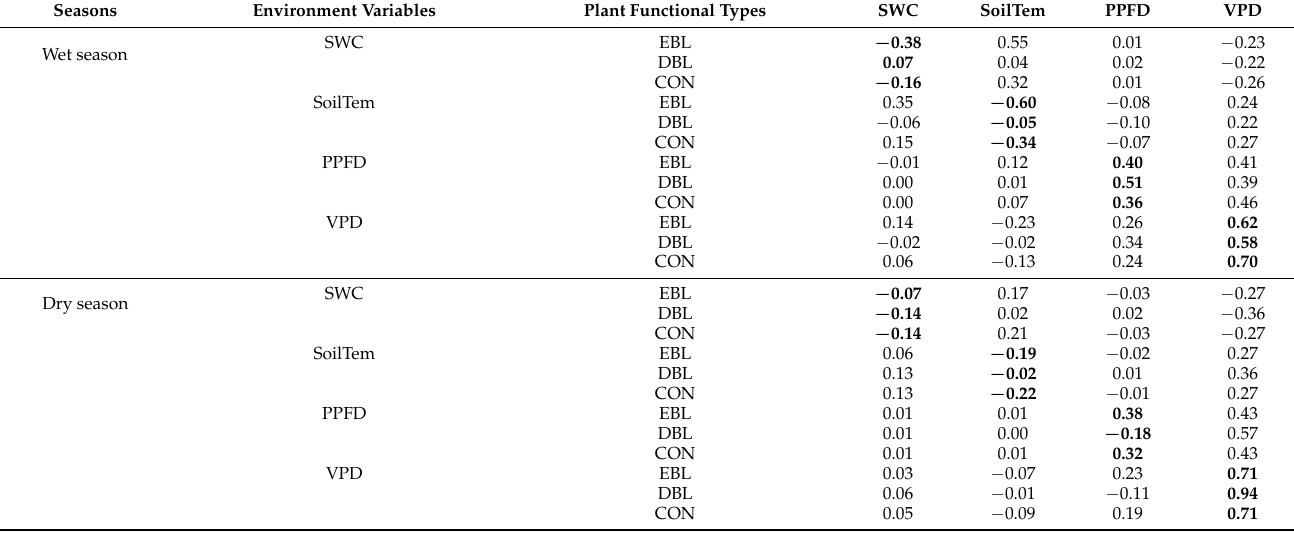
Table 3. Direct (in bold) and indirect effects of environment variables on sap flux densities of evergreen broad-leaved trees (EBL), deciduous broad-leaved trees (DBL), and conifers (CON) as revealed by path analysis at the diurnal course scale in the dry (from 25 July 2017 to 27 July 2017) and wet (from 17 January 2018 to 19 January 2018) season on sunny days.